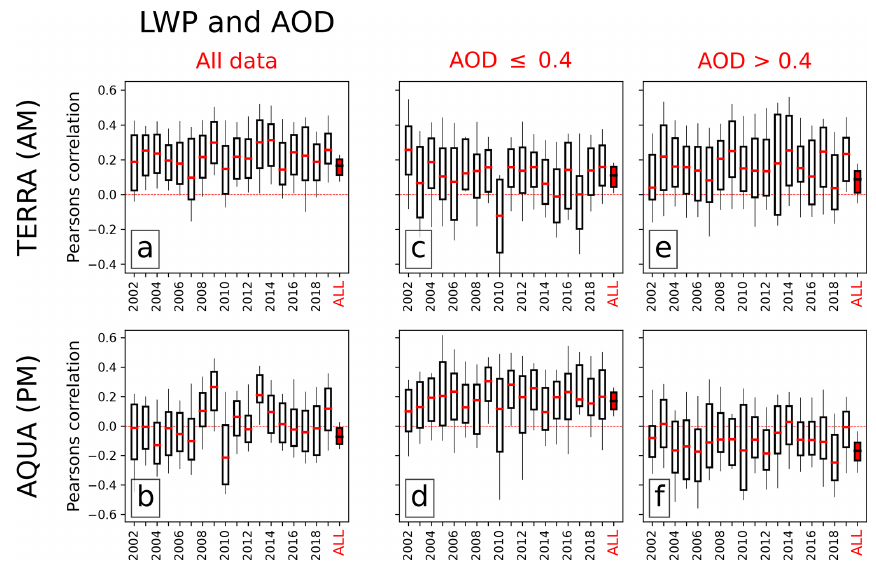
Figure 6. Boxplots showing Pearson’s correlation coefficients in the domain for the September of each individual year during the time series. Rows and columns are as in Fig. 5. The rightmost boxplot (in red) in each subplot shows the data for all years.